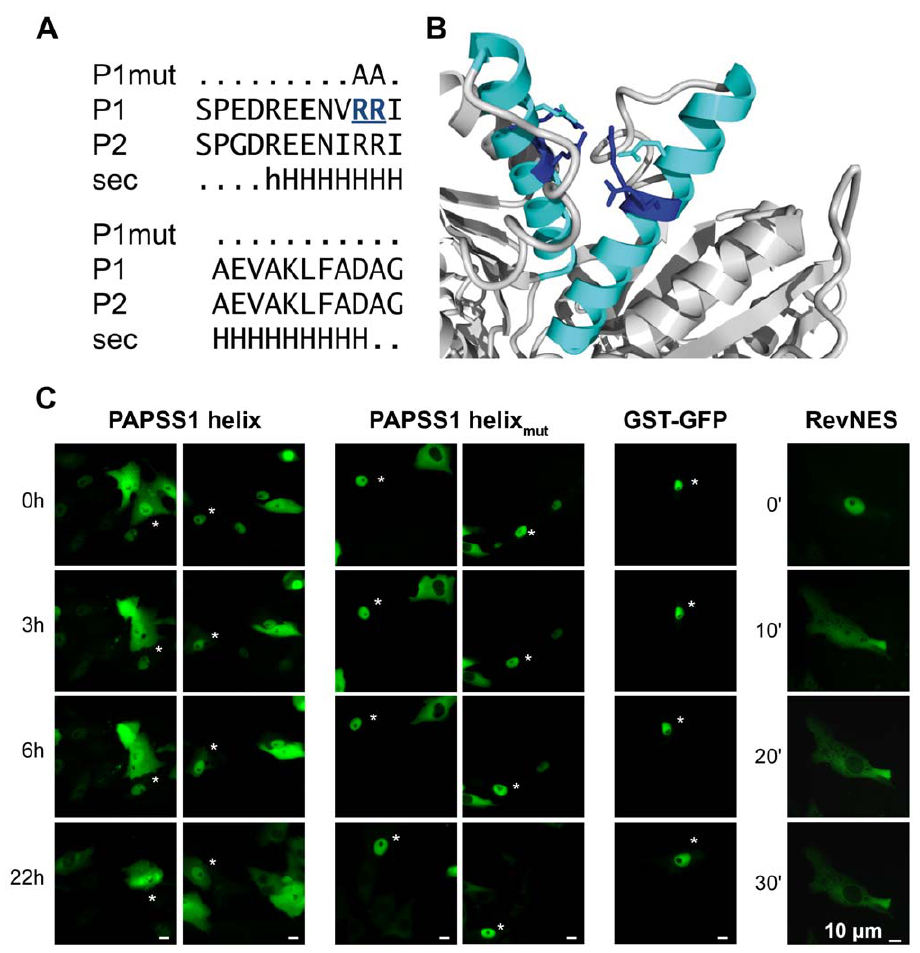
Figure 5. A positively charged helical structure in PAPSS1 shows export activity. A , alignment of residues Ser102-Gly124 of PAPSS1 (P1) and the respective Ser92-Gly114 sequence of PAPSS2 (P2). The two arginine residues targeted by alanine mutation are highlighted. NPS secondary structure consensus prediction confirms an extended a -helical conformation; ‘‘.’’, coil; h/H, weak/prominent helical propensity. B , mapping of this motif (cyan) on the interface of the APS kinase dimer within the PAPSS1 crystal structure 1X6V. The two arginine residues are shown in stick representation (blue). Additionally, Glu108 is shown in stick representation (cyan). This residue may be necessary for charge compensation. C , a recombinant GST-PAPSS1-Helix-GFP protein showed export activity upon microinjection into the nuclei of Vero cells at the indicated time points (left panels). In contrast, mutation of two arginine residues completely abolished nuclear export (middle panel), and the respective substrate remained nuclear as microinjected GST-GFP alone under the same experimental conditions (right panel). As a positive control, the Rev NES of HIV (LQLPPLERLTL) was completely exported from the nucleus within 30 min following microinjection. Approximately 50 cells were injected, and representative examples are